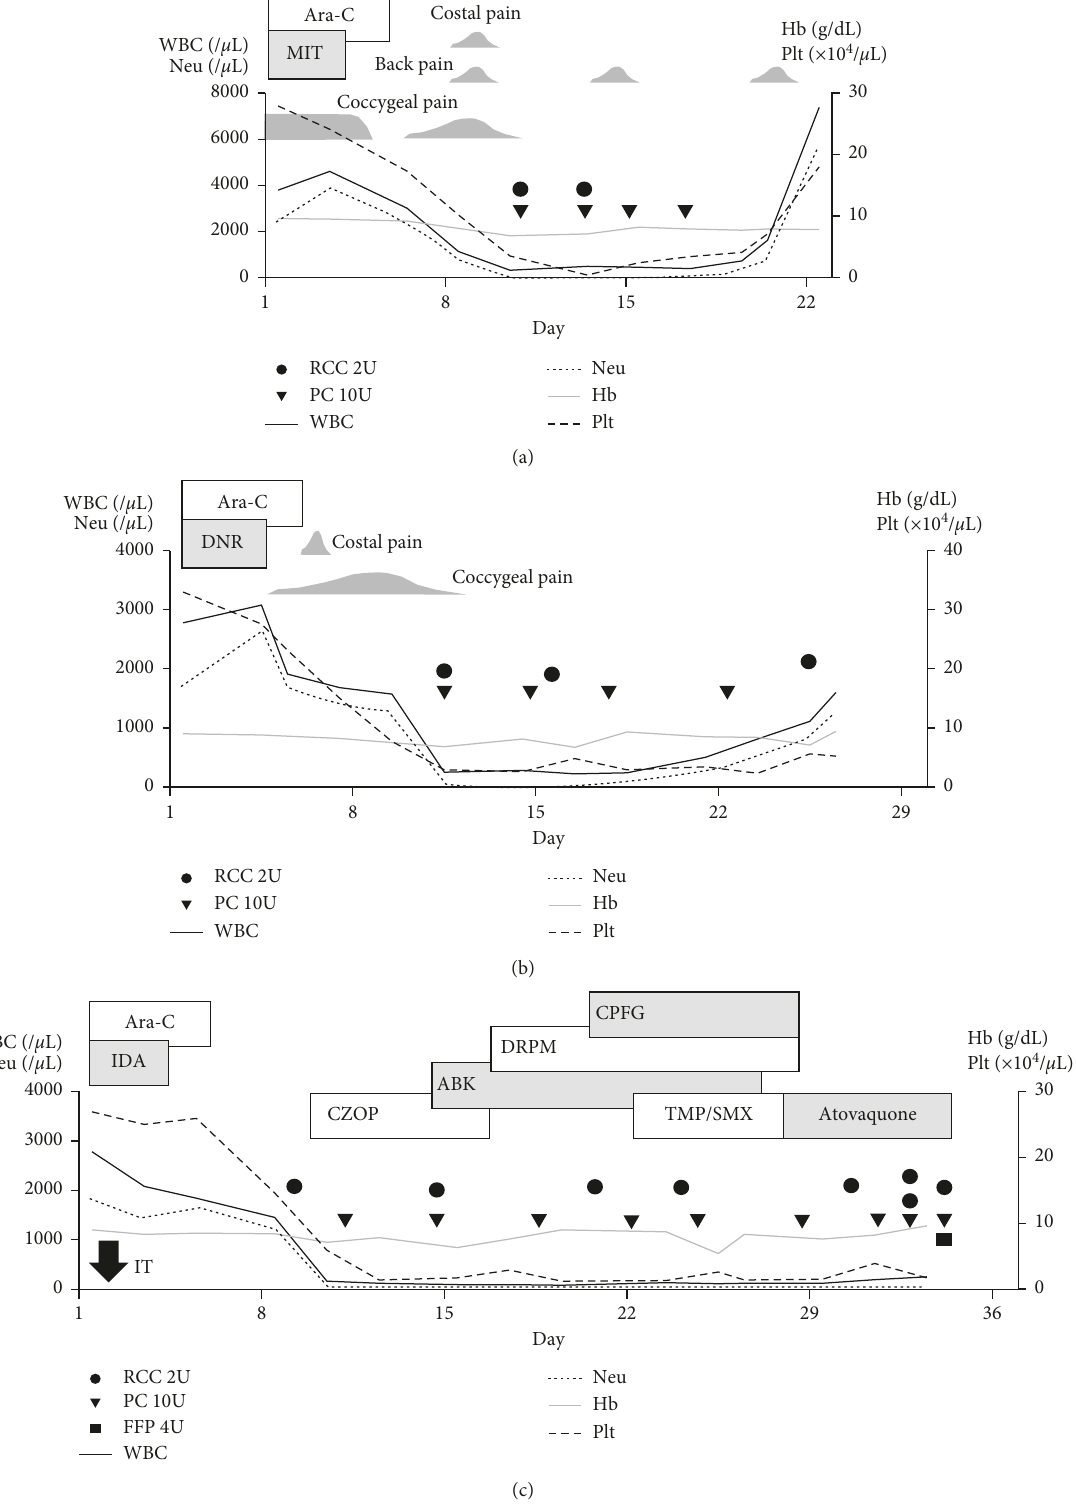
Figure 2: Prolonged myelosuppression during three courses of consolidation chemotherapy. (a) First course; (b) second course; (c)